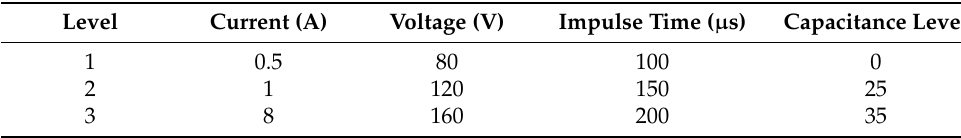
Table 3. Selected factors and experimental levels.